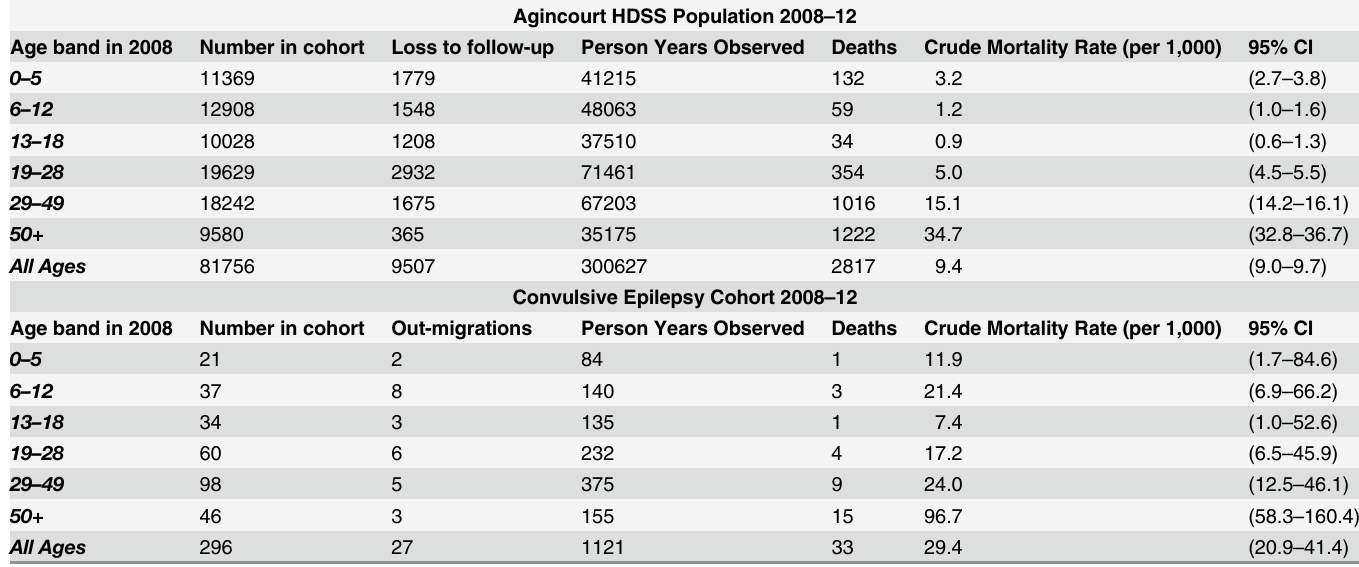
Table 1. Followed cohorts and outcomes of individuals and crude mortality rates, by age band, with and without ACE, Agincourt 2008 – 12.